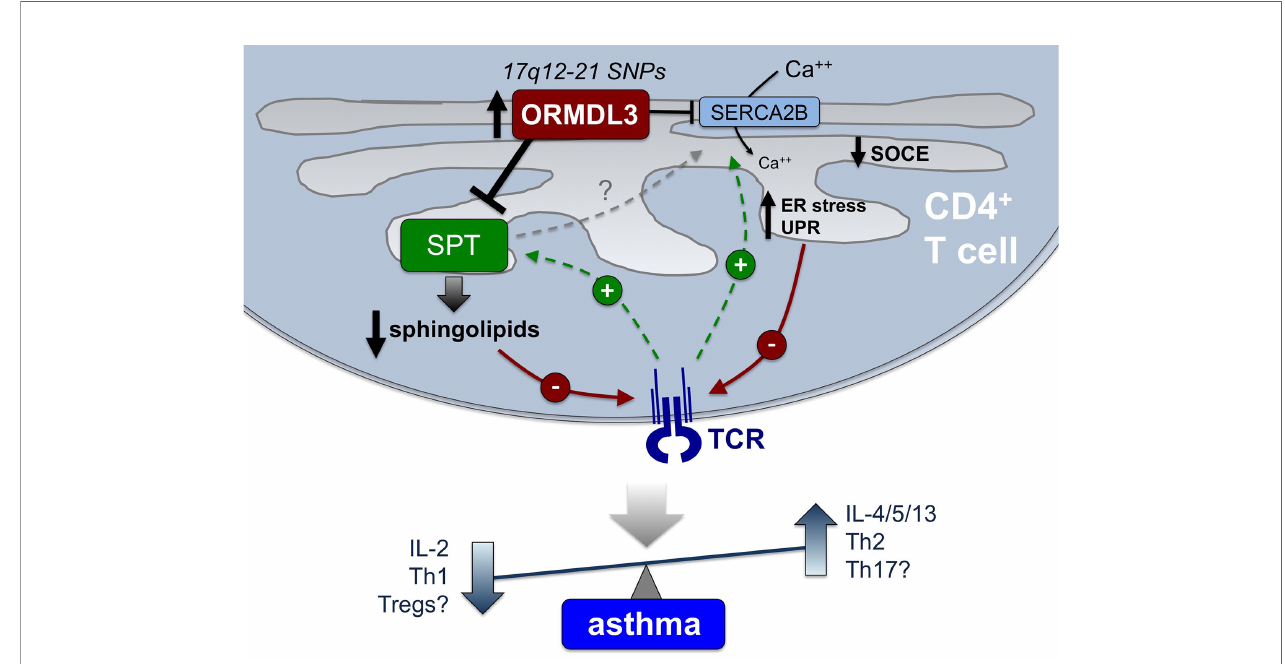
FIGURE 2 | Proposed mechanisms connecting elevated ORMDL3 expression in CD4+ T cells to asthma pathogenesis. In CD4 + T cells from those harboring 17q12-21 asthma risk SNPs, elevated ORMDL3 expression is thought to modulate the activity of both SPT and SERCA2B, both of which are normally enhanced after TCR stimulation (green lines). Consequently, we hypothesize that TCR signaling is diminished (red lines) via reduced/altered sphingolipid synthesis, as well as defective SOCE and reduced TCR-induced Ca ++ fl ux, and potential induction of ER stress and UPR. Attenuated TCR signaling and downstream T cell activation is known to result in reduced IL-2 production and skewing toward a Th2 phenotype (i.e. elevated IL-4, IL-5, and IL-13 secretion), highlighting a potential mechanistic association with allergic asthma pathogenesis that remains to be de fi nitively shown. Other outcomes (reduced Tregs, enhanced Th17 cells) may also contribute to in fl ammation and non-atopic asthma in certain patients. Based on fi ndings to date, we posit that altered sphingolipid synthesis via SPT regulation is the major driver of these changes in T cell differentiation and function, which may also indirectly in fl uence calcium homeostasis and ER stress via